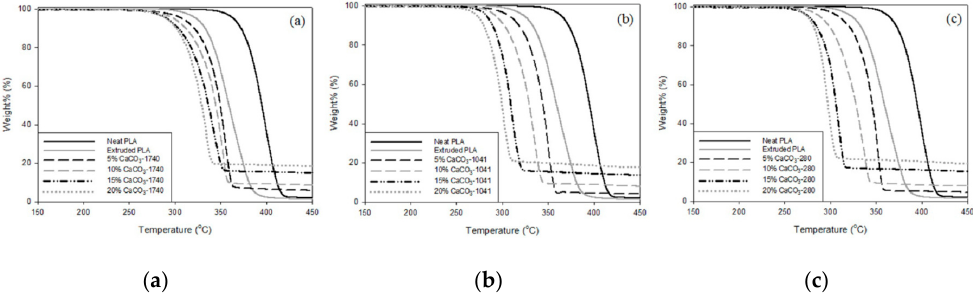
Figure 10. TGA curves of the CaCO 3 -PLA bio-composites with various loading of CaCO 3 : ( a ) micro-CaCO 3 -1740; ( b ) nano-CaCO 3 -1041; ( c ) nano-CaCO 3 -280 [44], Reproduced with permission from